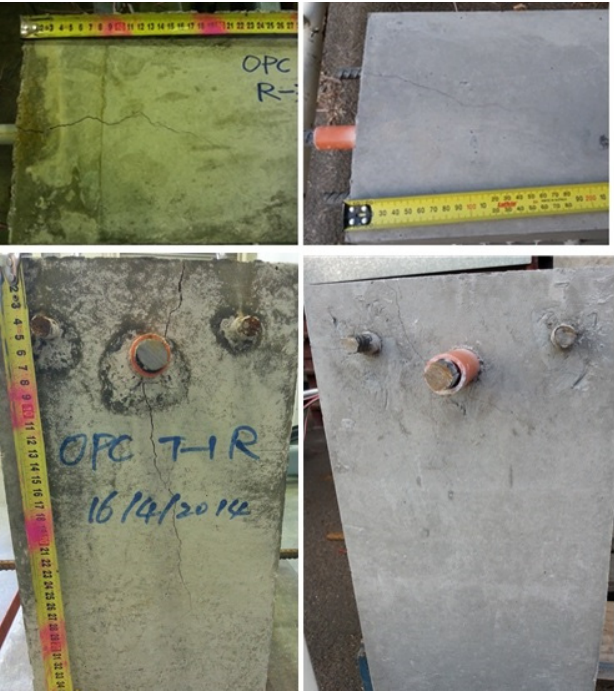
Figure 9. Comparison of the crack widths of OPC B-4 (left) and GPC B-6 (right). To study the differences in crack morphology between GPC and OPC, a few tested beams were cut and the concrete on top of the reinforced bars was removed to explore the nature of the interaction at the steel–concrete interface.